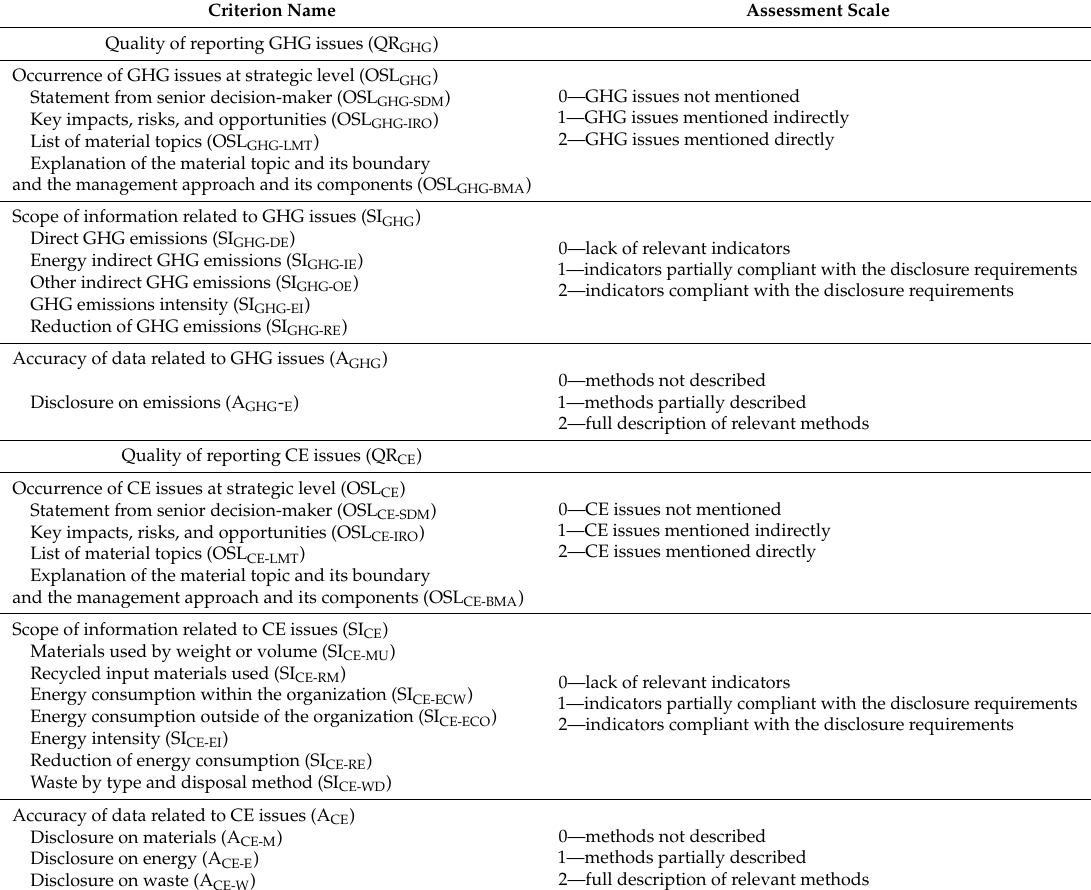
Table A4. Assessment criteria and applied scoring